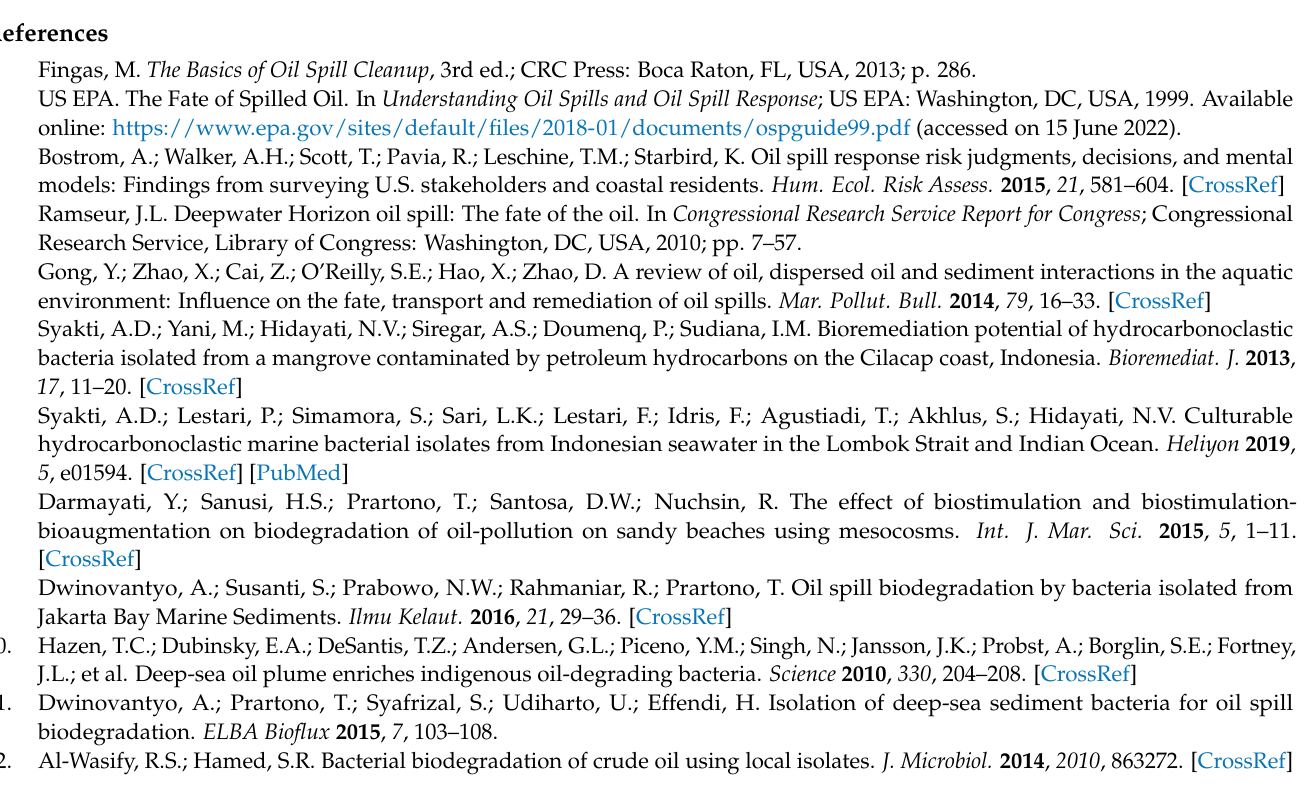
Figure S2: Content change of aromatics compounds found in crude oil (a) before and (b) after biodegradation from mass spectra raw data of GC-MS